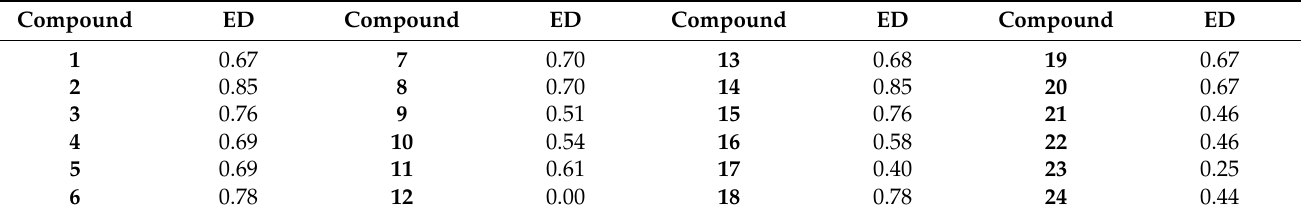
Table 5. The similarity parameter (ED) for experimental and calculated lipophilicity for hybrids 1 – 210 24 .